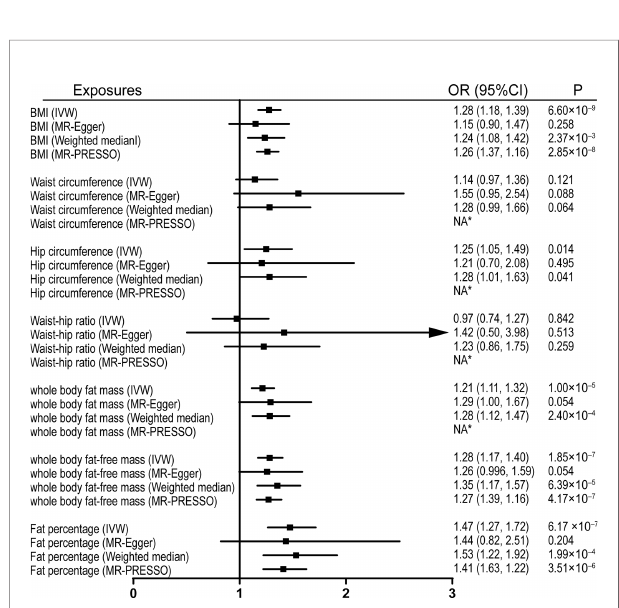
FIGURE 2 | Effects of obesity-related exposures on LBP. Results from univariable MR analyses showing the effects of genetically proxied BMI and obesity-related traits on LBP with IVW, MR-Egger, weighted median, and MR-PRESSO methods. *No outlier detected. IVW, inverse-variance weighted; BMI, body mass index; LBP, low back pain; OR, odds ratio; CI, con fi dence interval; MR, Mendelian randomization. NA, not